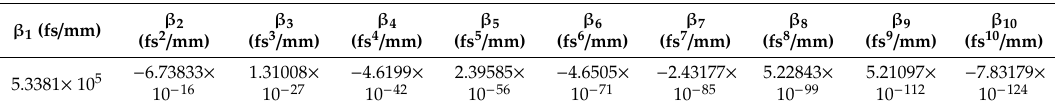
Table 3. Values of 1–10 order of dispersion coe ffi cients of SCF with d = 1 µ m and a = 0.18 µ m − 1 at 1.541 µ